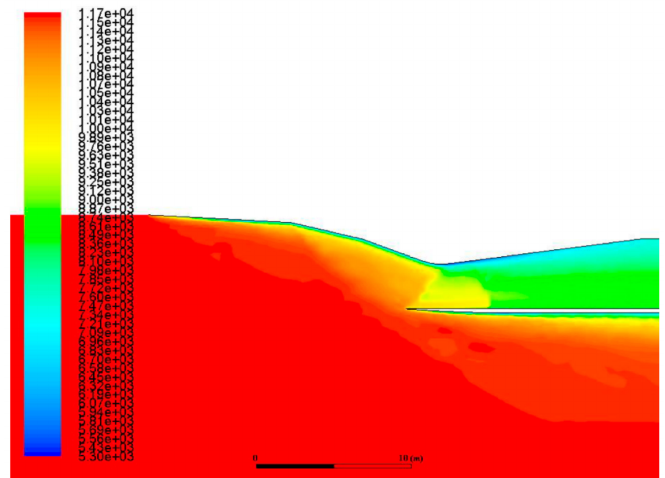
Figure 4. Mach 2.5 total pressure